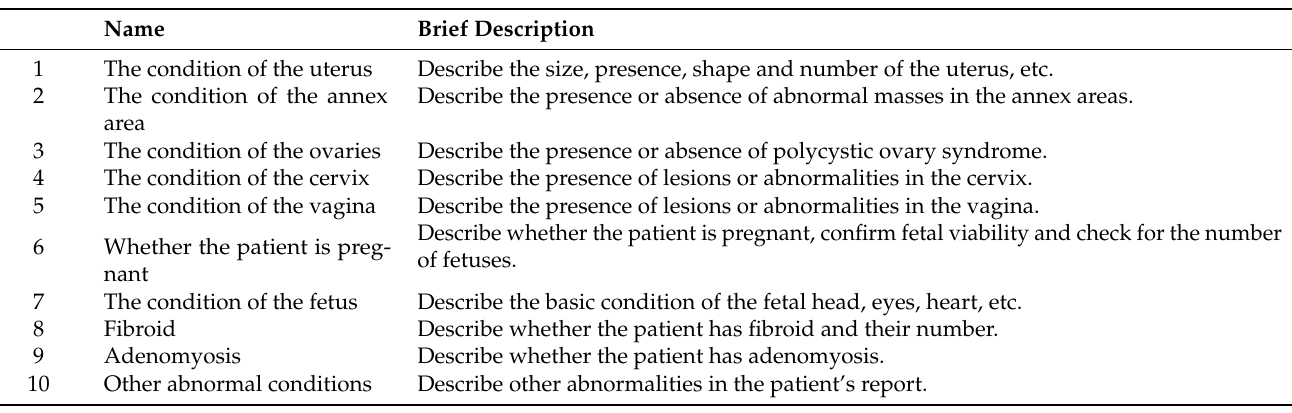
Table 8. Ten common items in ultrasound reports.